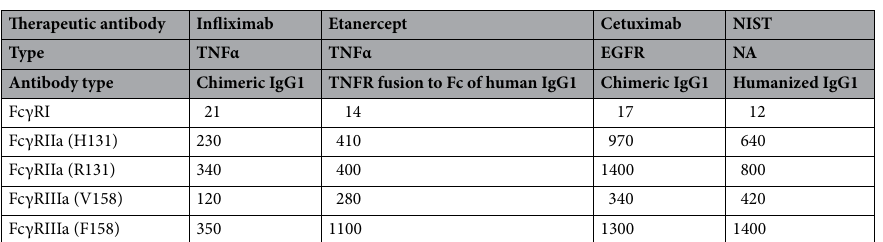
Table 2. K D (nM) values of four antibodies against five different FcγRs determined using